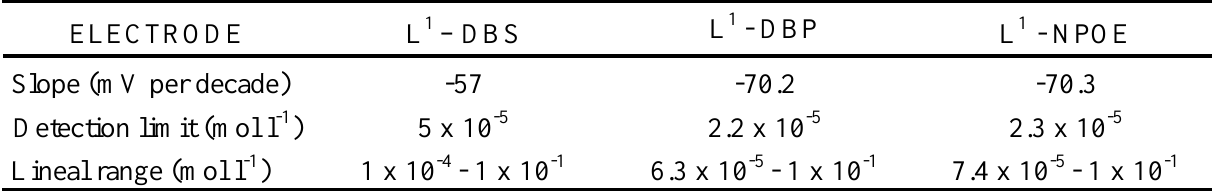
Table 1 . Response characteristics of the different perchlorate-selective electrodes in thick-film